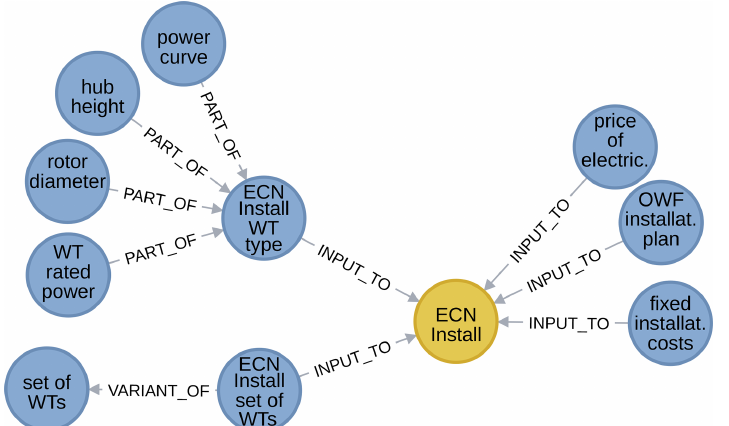
Figure 14. An example of limiting tool-specific variable nodes (excerpt from WESgraph).